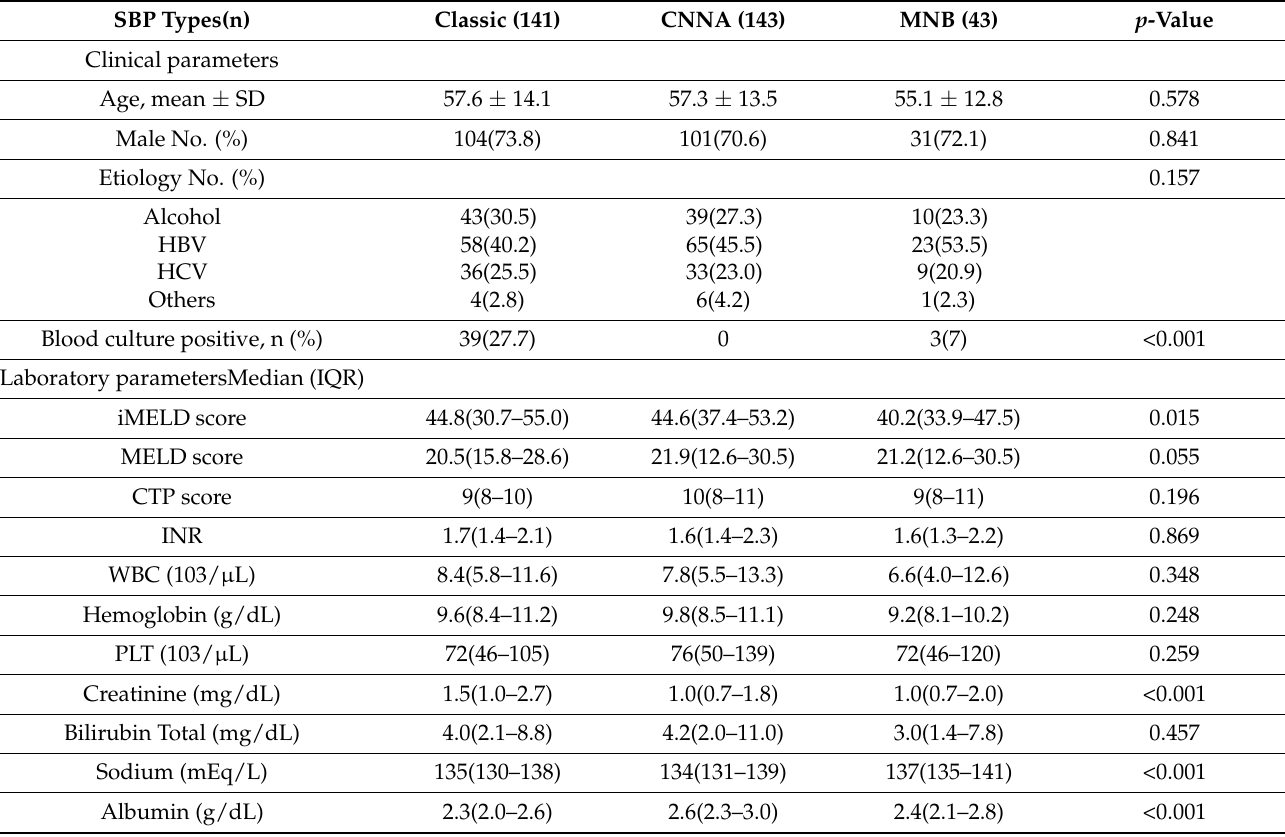
Table 2. Demographic and baseline clinical characteristics of three types of